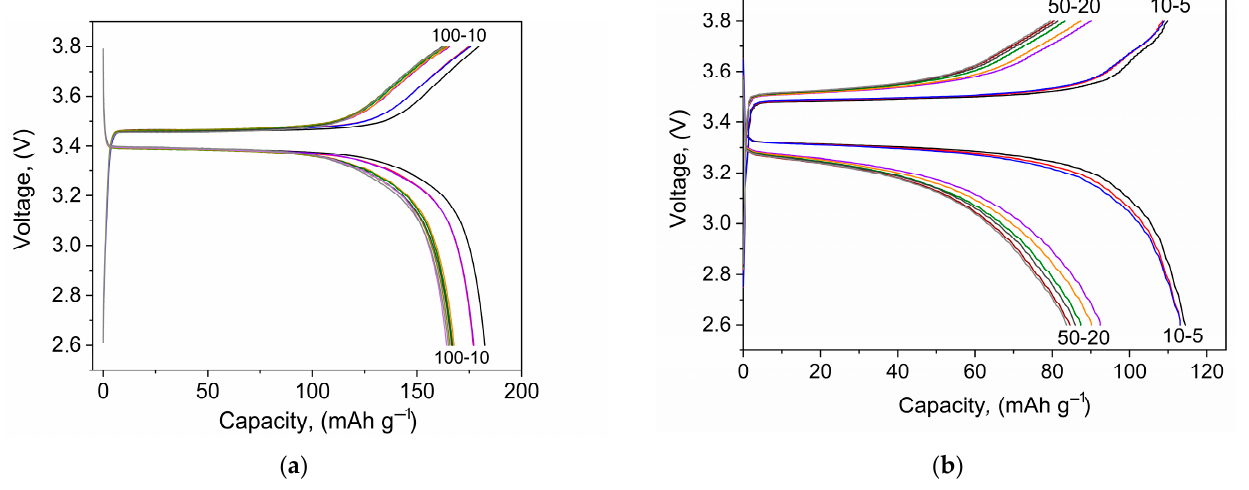
Figure 3. Charge and discharge curves of the Li//LiFePO 4 cells, where ( a ) with LiTFSI–DOL-DME and ( b ) “dry assembly” at the C/10 current rate in a voltage range of 2.6–3.8 V.